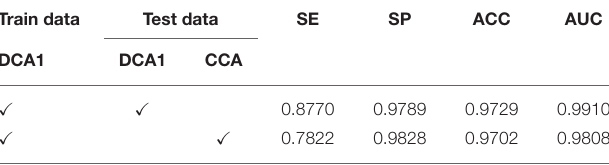
TABLE 8 | Results of experiments on the generalization